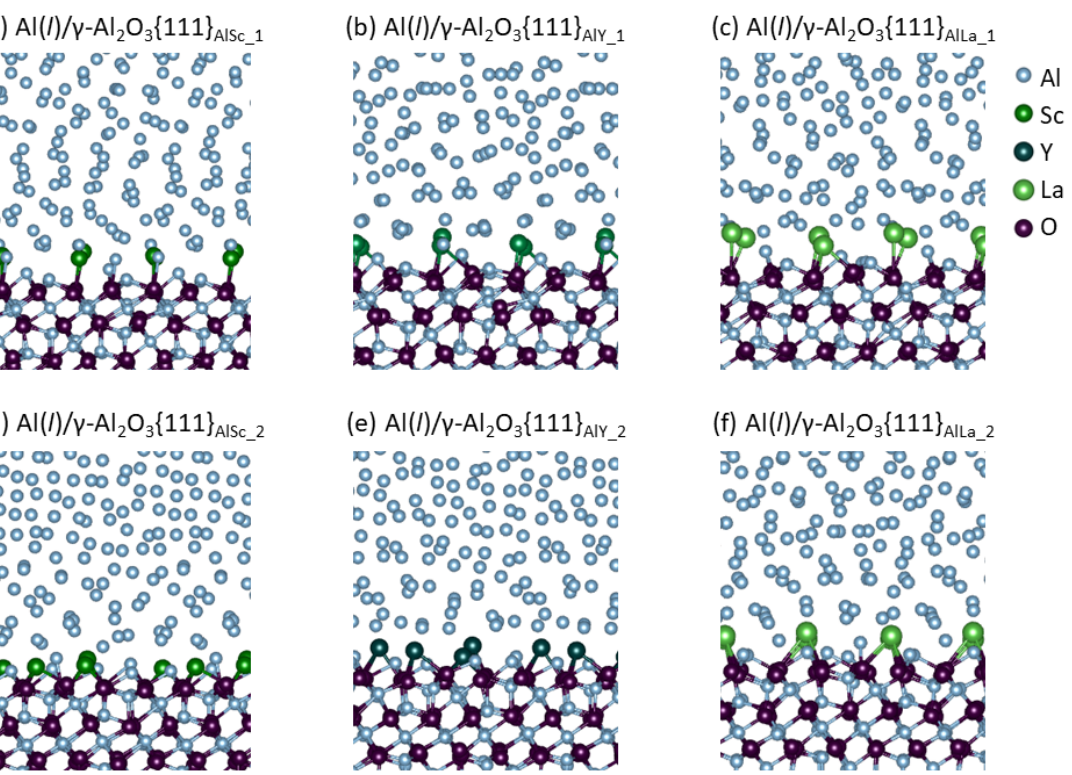
Figure 1. Snapshots of the Al( l )/ γ -Al 2 O 3 {1 1 1} AlM systems equilibrated at 900 K and at simulation time 6 ps. The chemical bonds between O and the metal atoms are indicated. The segregated Group 3 atoms are positioned between the terminating and the 1st Al layers and bonded to the outmost O atoms. ( a ) Al( l )/ γ -Al 2 O 3 {111} AlSc_1 , ( b ) Al( l )/ γ -Al 2 O 3 {111} AlY_1 , ( c ) Al( l )/ γ -Al 2 O 3 {111} AlLa_1 , ( d ) Al( l )/ γ -Al 2 O 3 {111} AlSc_2 , ( e ) Al( l )/ γ -Al 2 O 3 {111} AlY_2 , ( f ) Al( l )/ γ -Al 2 O 3 {111} AlLa_2 .